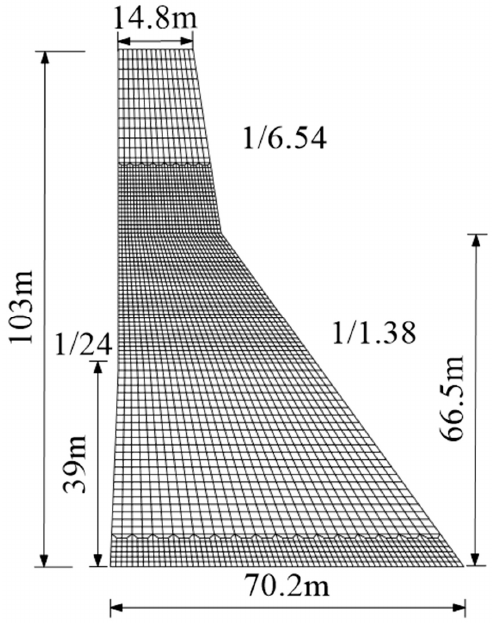
Figure 7. Detailed plot of the 2D FE model of the Koyna dam.